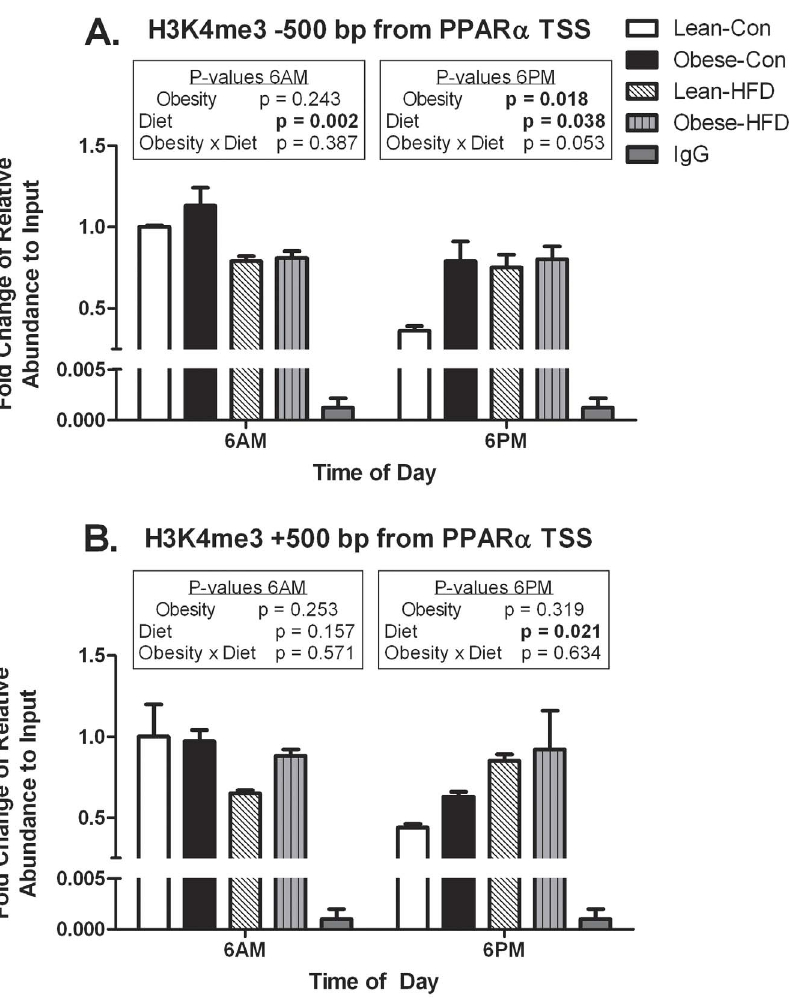
Figure 4. H3K4me3 enrichment on the PPAR a promoter. Chromatin immunoprecipitation for H3K4me3 was carried out and A) upstream ( 2 500 base pairs) and B) downstream ( + 500 base pairs from TSS) regions of the PPAR- a gene were amplified in pools of liver samples (each pool represents 3–5 separate animals) from offspring of lean or obese dams fed either control or HFD (run in triplicate). Enrichment was determined by real time RT-PCR and normalized to input levels. Data are presented as mean 6 SEM. Statistical differences were determined using a two-way ANOVA to examine the effects of maternal obesity and post-weaning HFD. Significant interactions were followed by one way ANOVA and Student-Newman- Keuls post hoc analyses (P , 0.05). Bold values represent significant main effects and interactions and values with different letter superscripts are significantly different from each other (P , 0.05).